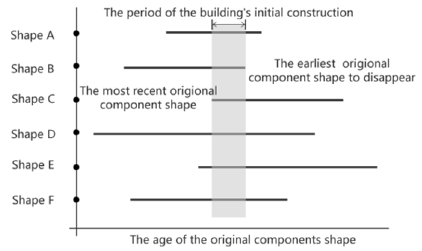
Figure 8. Schematic diagram of simultaneity principle of the same building [51].